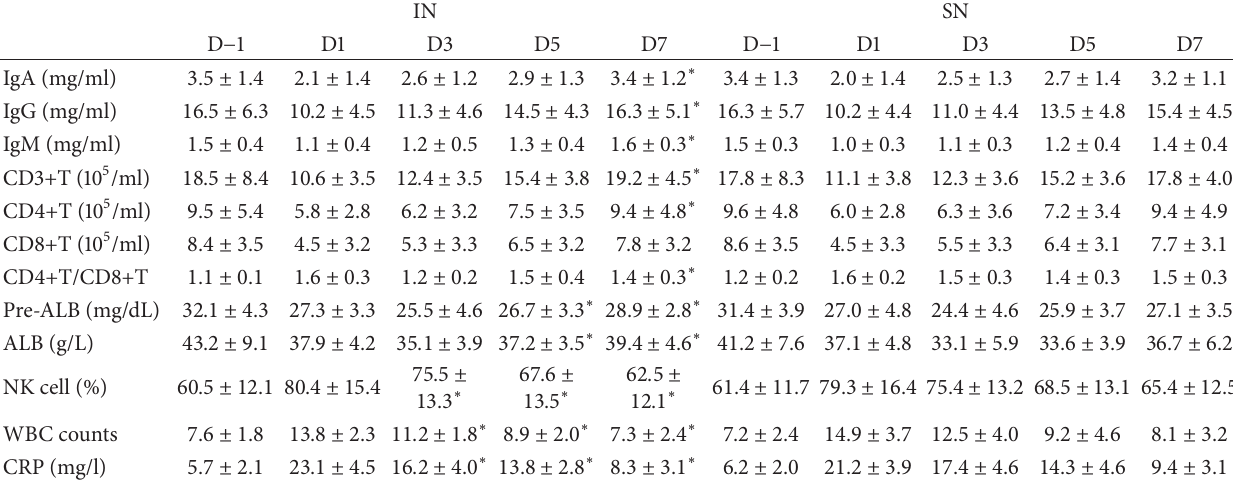
Table 5: Inflammatory and immunobiomarkers between two